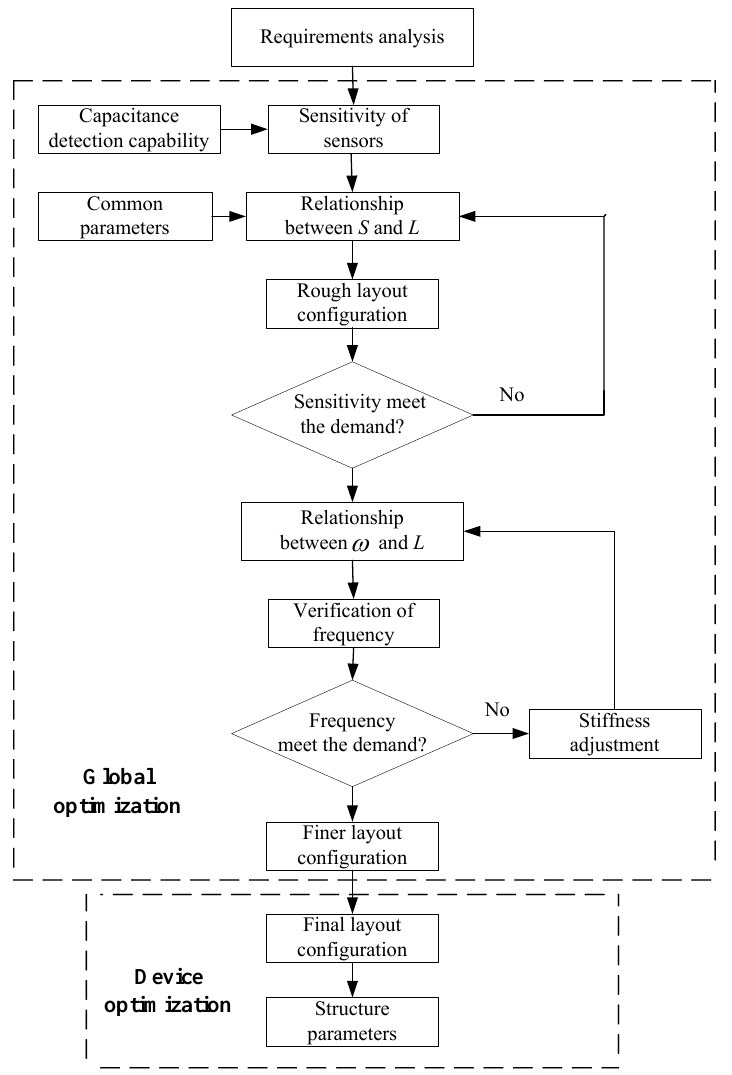
Figure 5. The flow of the proposed global optimization approach.